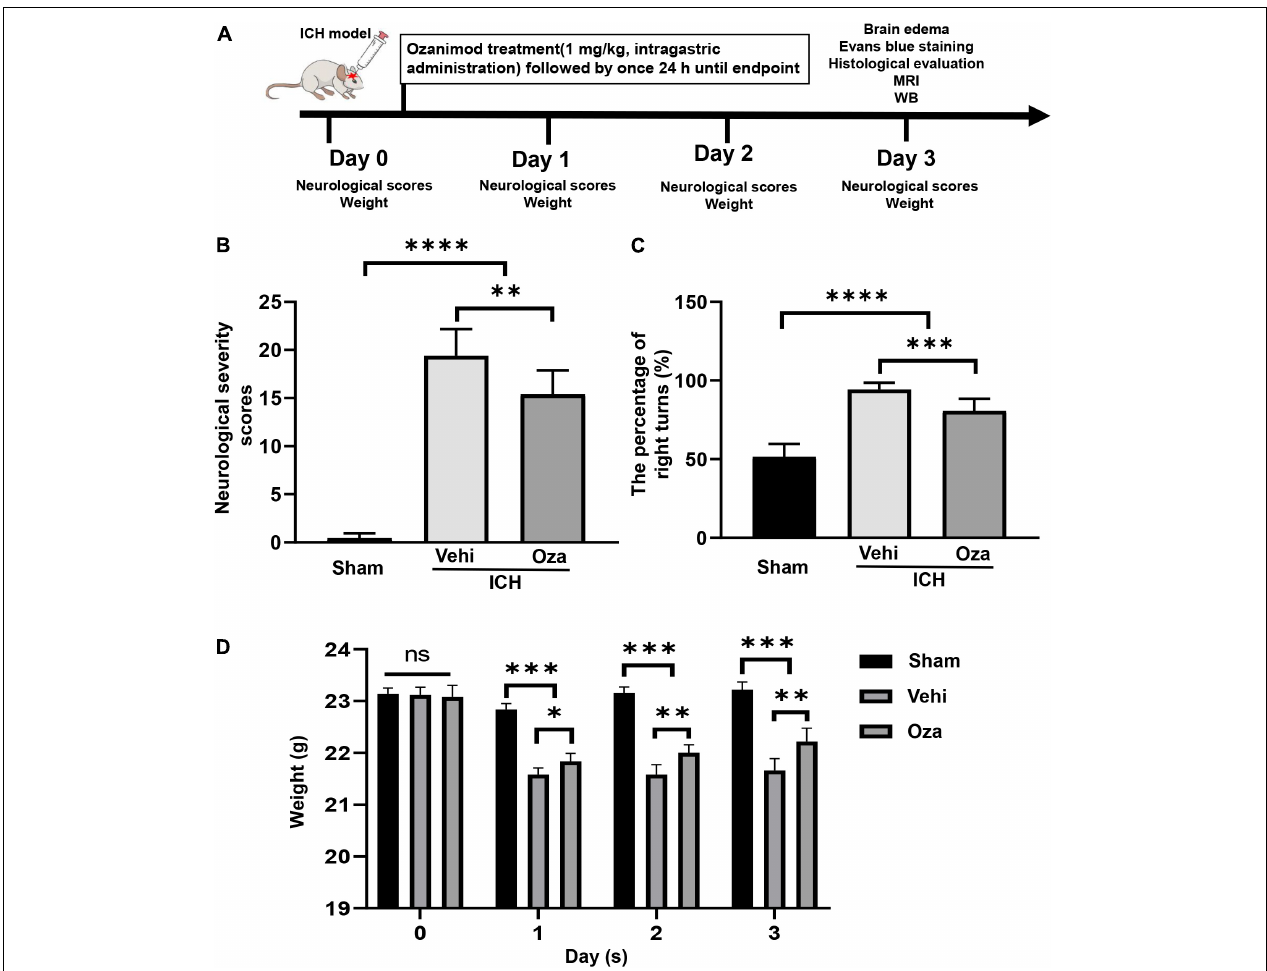
FIGURE 1 | The effects of Ozanimod on neurological function and weight changes in mice after ICH. (A) Flow chart of animal experiments. (B,C) Ozanimod improved functional results on the neurological severity scores and corner turn test ( n = 6). (D) Ozanimod reduced postoperative weight loss in mice ( n = 5). Data are presented as mean ± SD . ∗ p < 0.05, ∗∗ p < 0.01, ∗∗∗ p < 0.001, ∗∗∗∗ p <